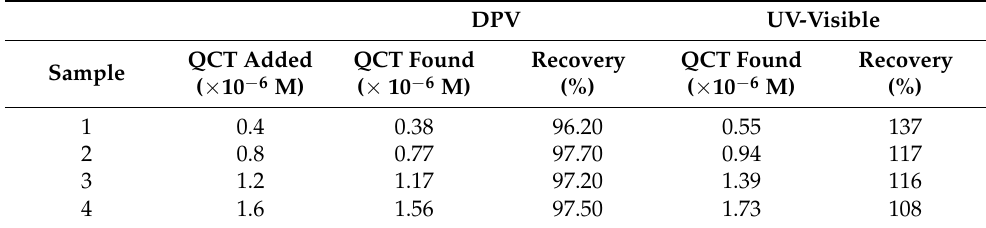
Table 2. Determination of QCT in urine